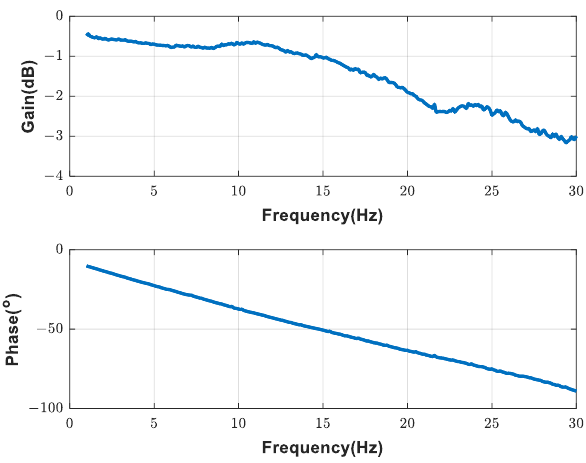
Figure 11. Experimental FRF of the actuator system.